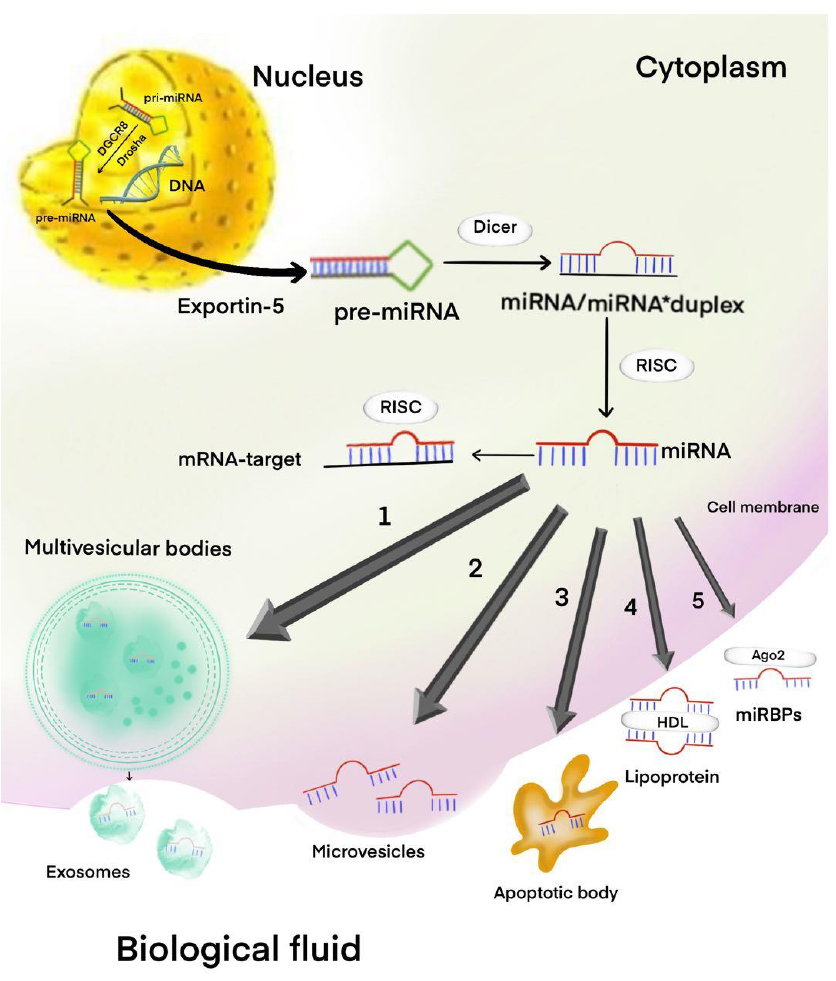
Figure 1. MicroRNA (miRNA) biogenesis and release of miRNAs in the extracellular environment. Pri-miRNA processed by Drosha / DGCR8 to pre-miRNA. Exportin-5 transfers these pre-miRNAs from nucleus to cytoplasm, where the dicer processes them into mature miRNAs. Mature miRNAs can be selectively incorporated into the exosomes ( 1 ), microvesicles ( 2 ), apoptotic body ( 3 ), high-density lipoprotein (HDL) ( 4 ), or coupled with miRNA and RNA-binding proteins (miRBPs) like Ago2 protein ( 5 ) and released in to biological fluid.